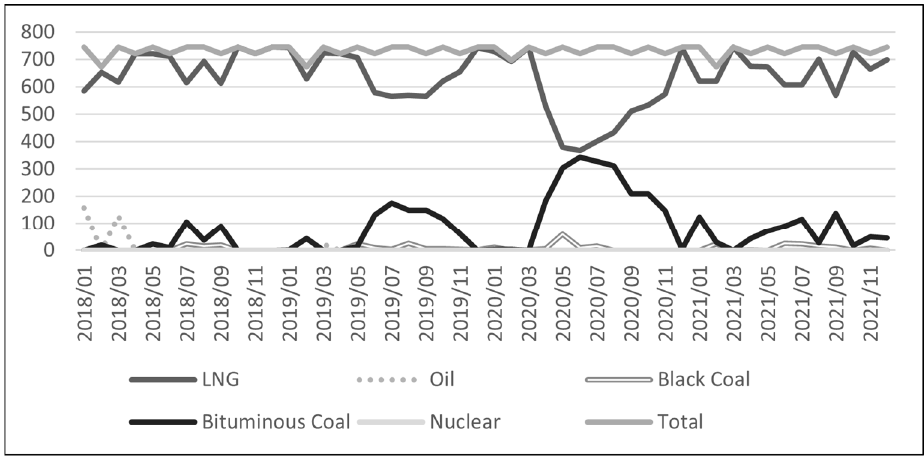
Figure 2. SMP determination frequency by fuel type.